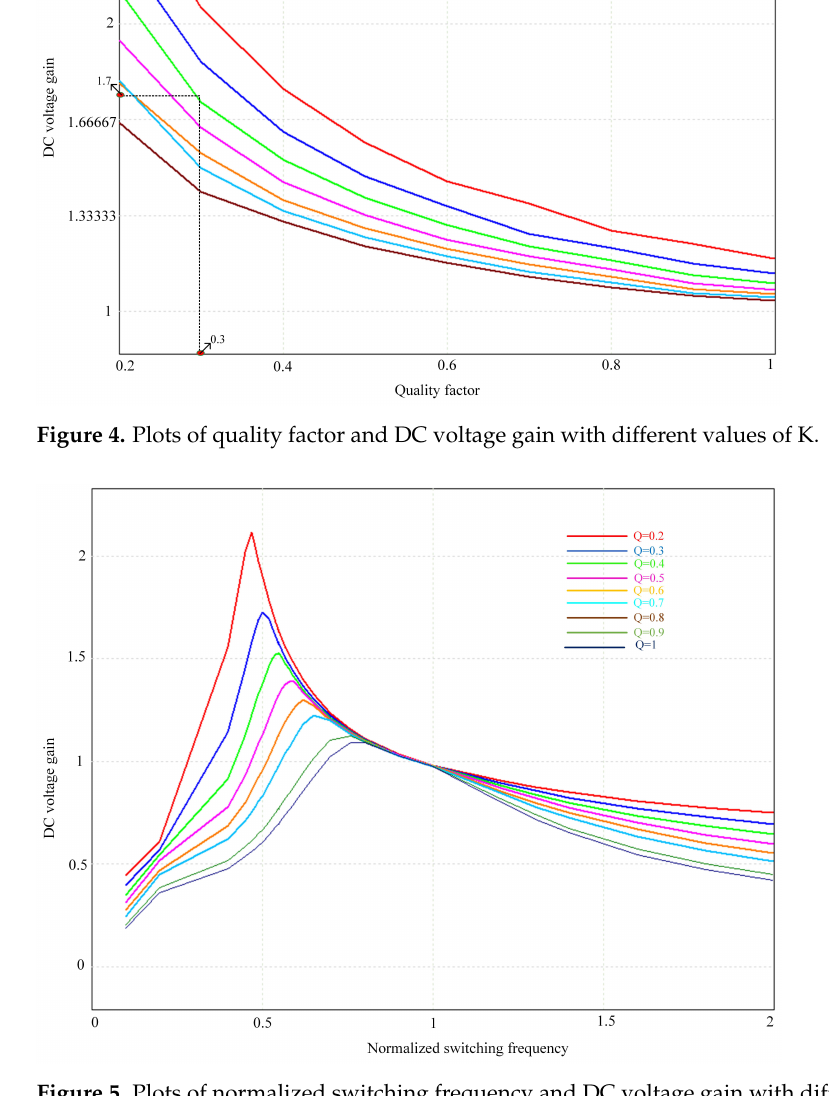
Figure 5. Plots of normalized switching frequency and DC voltage gain with different values of